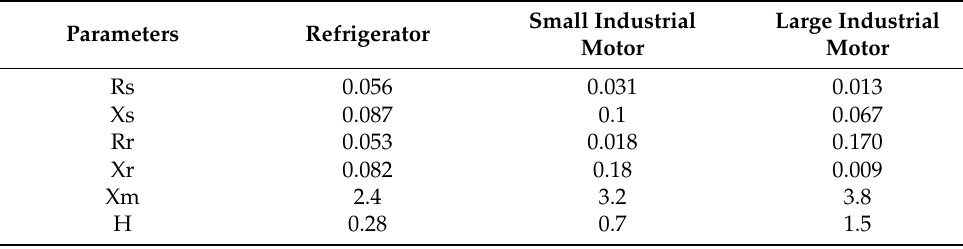
Table A1. Motor load parametrization in p.u.